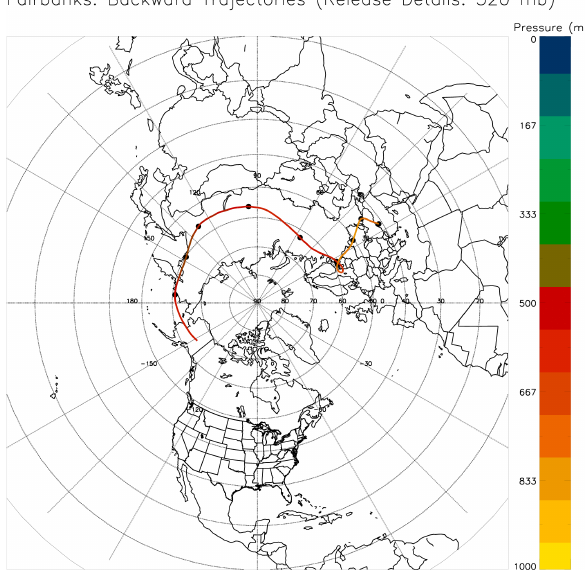
Fig. 16. FLEXPART back trajectory ending 15 April 2008 at 520hPa over Fairbanks, Alaska. Each black dot represents one day. Large red circles indicate regions of southeast Siberian fire